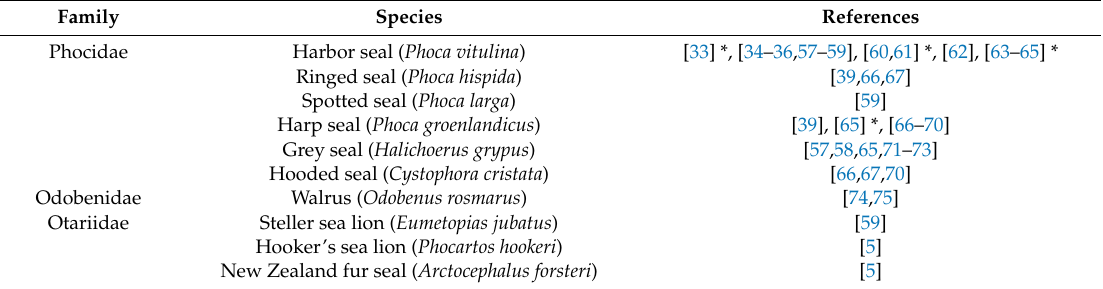
Table 1. Pinniped species infected with phocine distemper virus.